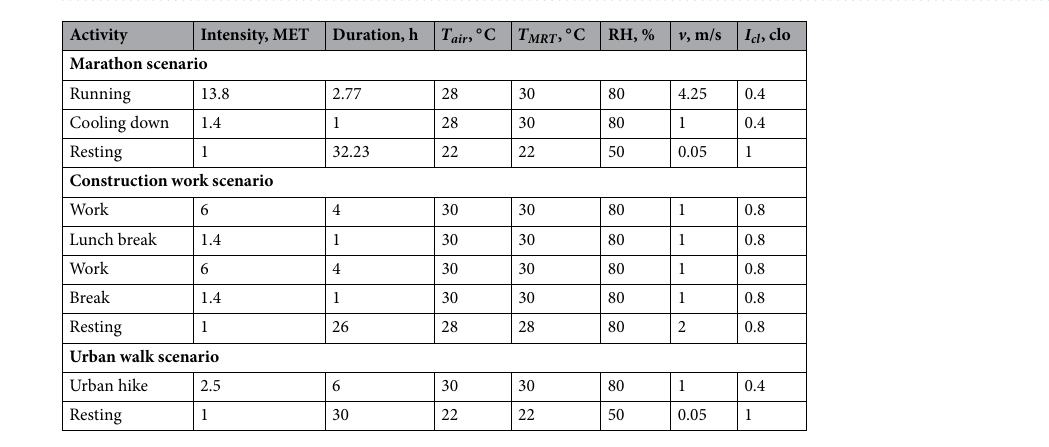
Figure 4. The dynamics of core temperature as a function of time and level of activity intensity. (a) For sunny outdoor environment of Singapore, (b) for cloudy outdoor conditions of Singapore, (c) for cloudy morning conditions with air velocity V air = 3.9 m/s = 14 km/h equivalent to air velocity around running person (vigorous physical activity). Contour lines indicate the regimes of activity intensity and its duration resulting in the same value of core temperature T core . T core > 38.0 ◦ C is predicted by our model to have detrimental effects on the performance of immune response. Thus, intensity and duration of activity in a given environment, for which T core exceeds 38.0 ◦ C , should be avoided to minimise the risk of compromising the immune system.